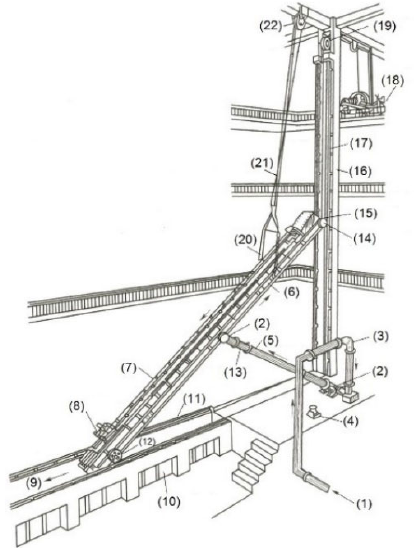
Figure 10. Large test rig of chute spillway aerator at IWHR. The flume is 15.0 m long and 0.2 wide, with its angle adjustable between α = 0–49°. (1) water from pump; (2) rotatable pipe joint; (3) flow meter; (4) control valve; (5) water supply pipe; (6) water supply in flume bottom; (7) test flume with aerator; (8) 3D measurement carriage; (9) tailwater; (10) observation window; (11) horizontal rail; (12) horizontally moving wheel; (13) expansion pipe section; (14) vertically moving wheel; (15) water intake to flume; (16) counterweight (not shown); (17) vertical rail; (18) hoister; (19) safety brake; (20) lifting cradle; (21, 22) lifting wire and guide